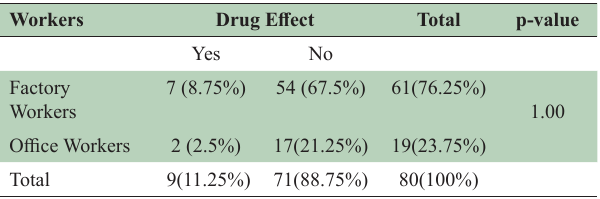
p-value 01 (Insignificant).